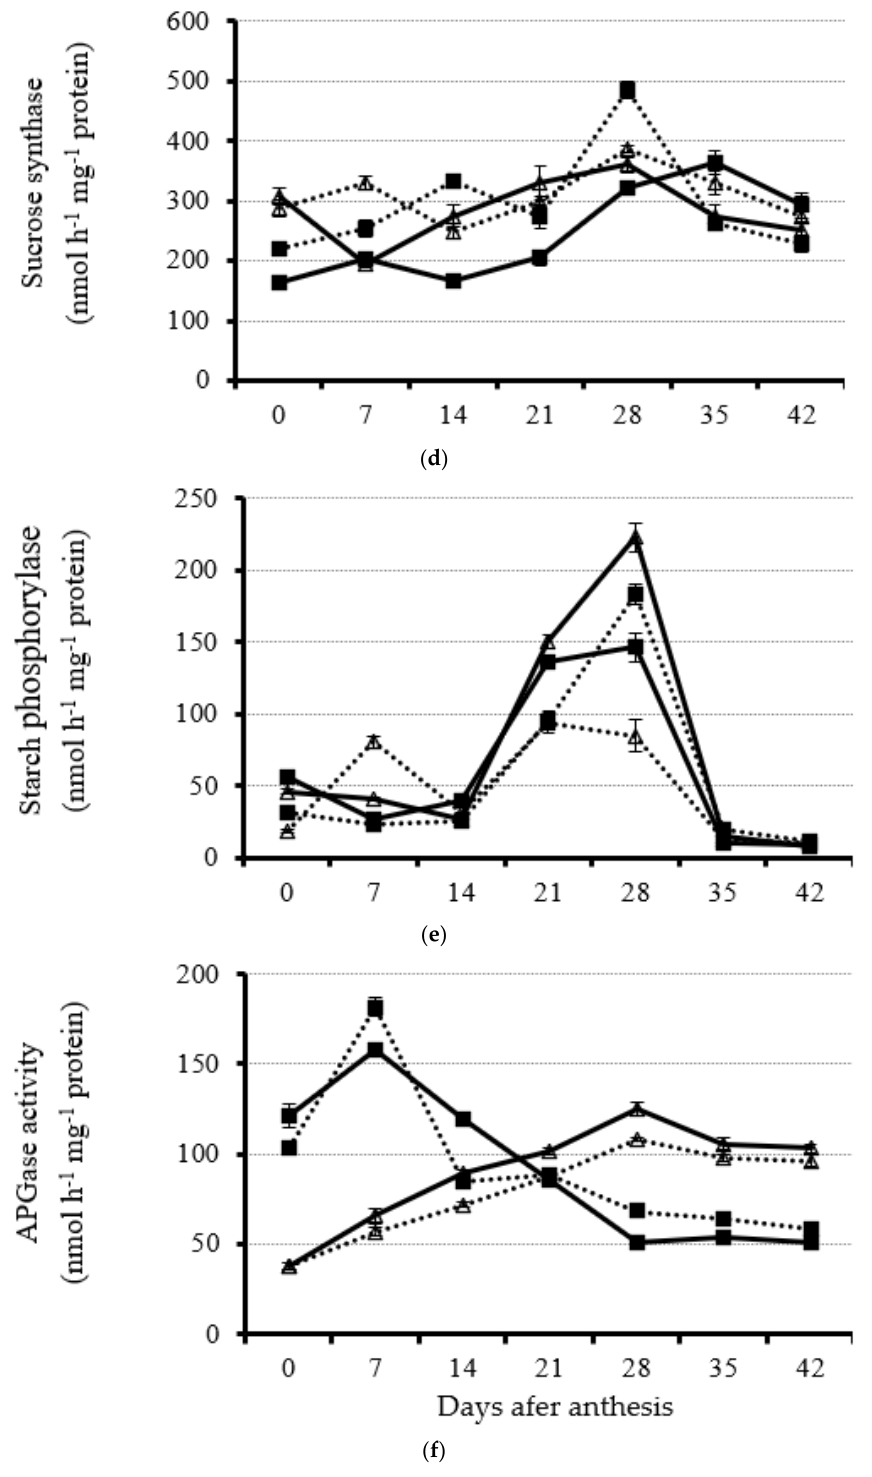
Figure 4. Dynamic of leaf acid invertase ( a ), neutral inverse ( b ), sucrose phosphate synthase ( c ), sucrose synthase ( d ), starch phosphorylase ( e ), and AGPase ( f ) activity from anthesis with a 7 d interval under four planting dates—early, optimal, late, and very late (15 September, 1 October, 15 October, and 30 October, respectively)—in 2020. Bars of each value are standard